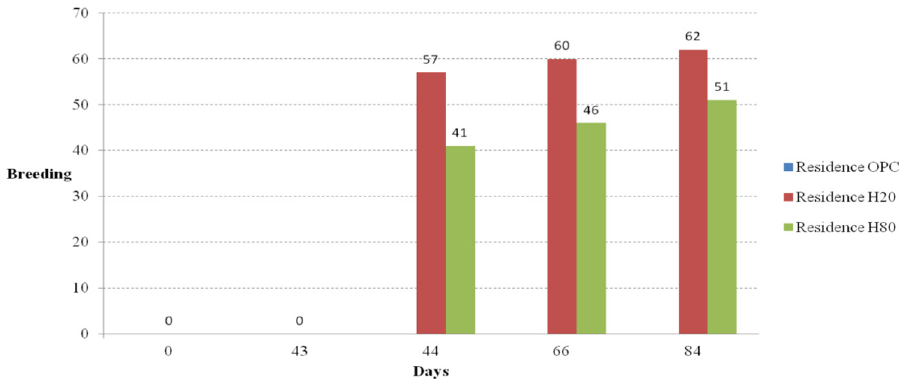
Figure 19. Breeding versus time curve (floor cages).